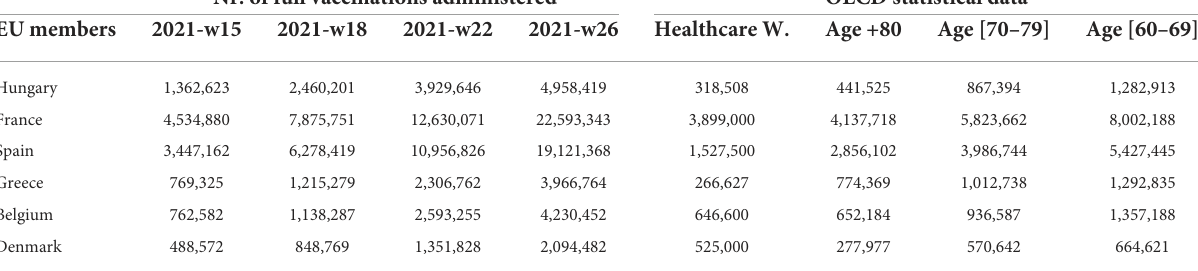
TABLE 1 Table reporting actual data about full vaccinations administered (primary course) at weeks 15, 18, 22, 26 of 2021 and the population by priority class according to the